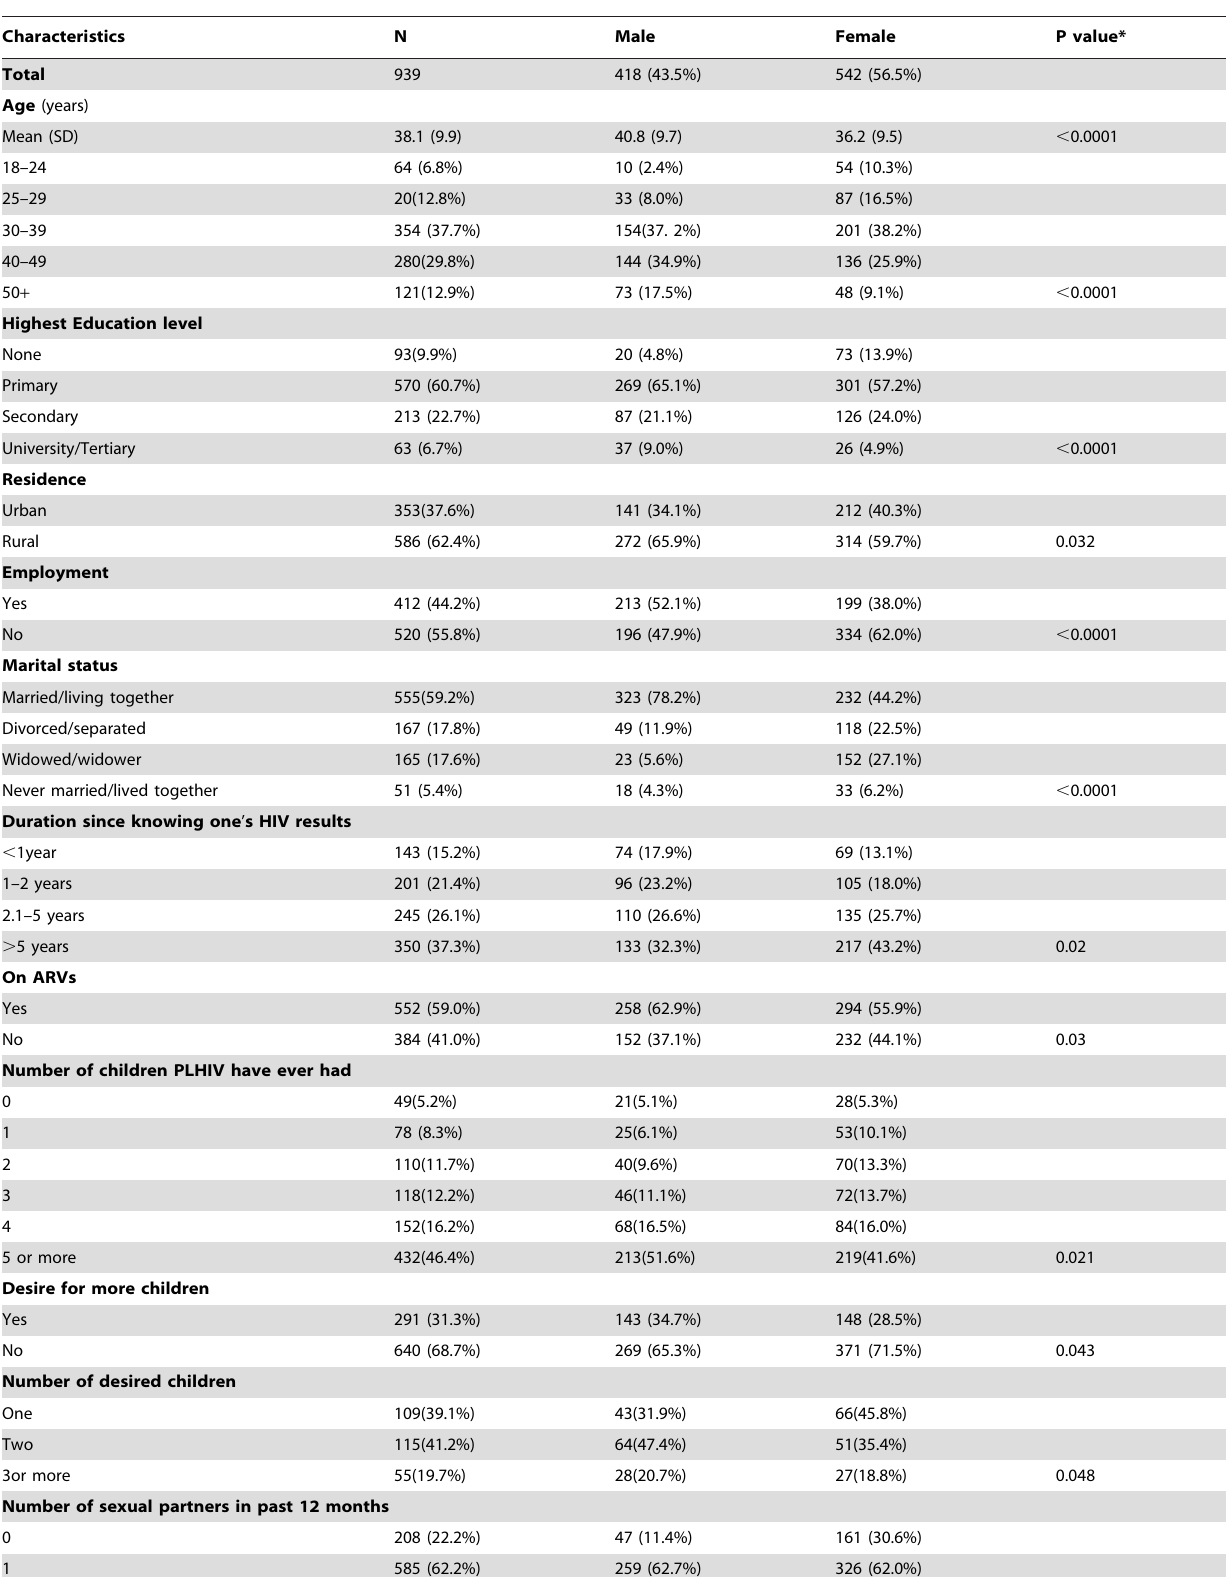
Table 1. Selected Characteristics of the study population (n=939).